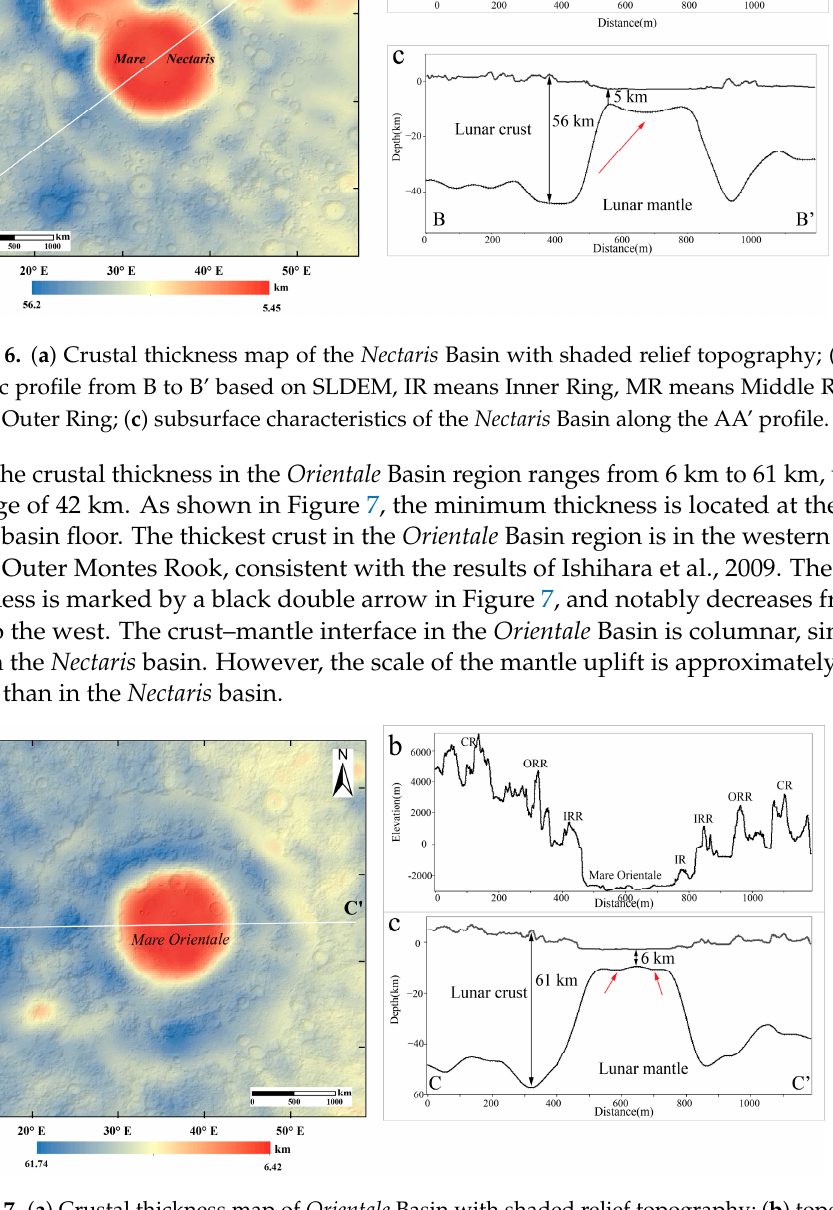
Figure 7. ( a ) Crustal thickness map of Orientale Basin with shaded relief topography; ( b ) topographic profile from C to C’ based on LOLA, IR means Inner Ring, IRR means Inner Rook Ring, ORR means Outer Rook Ring, and CR means Cordillera Ring; ( c ) subsurface characteristics of Orientale Basin along with the AA’ profile. Red arrows indicate subsidence of the crust and mantle interface.